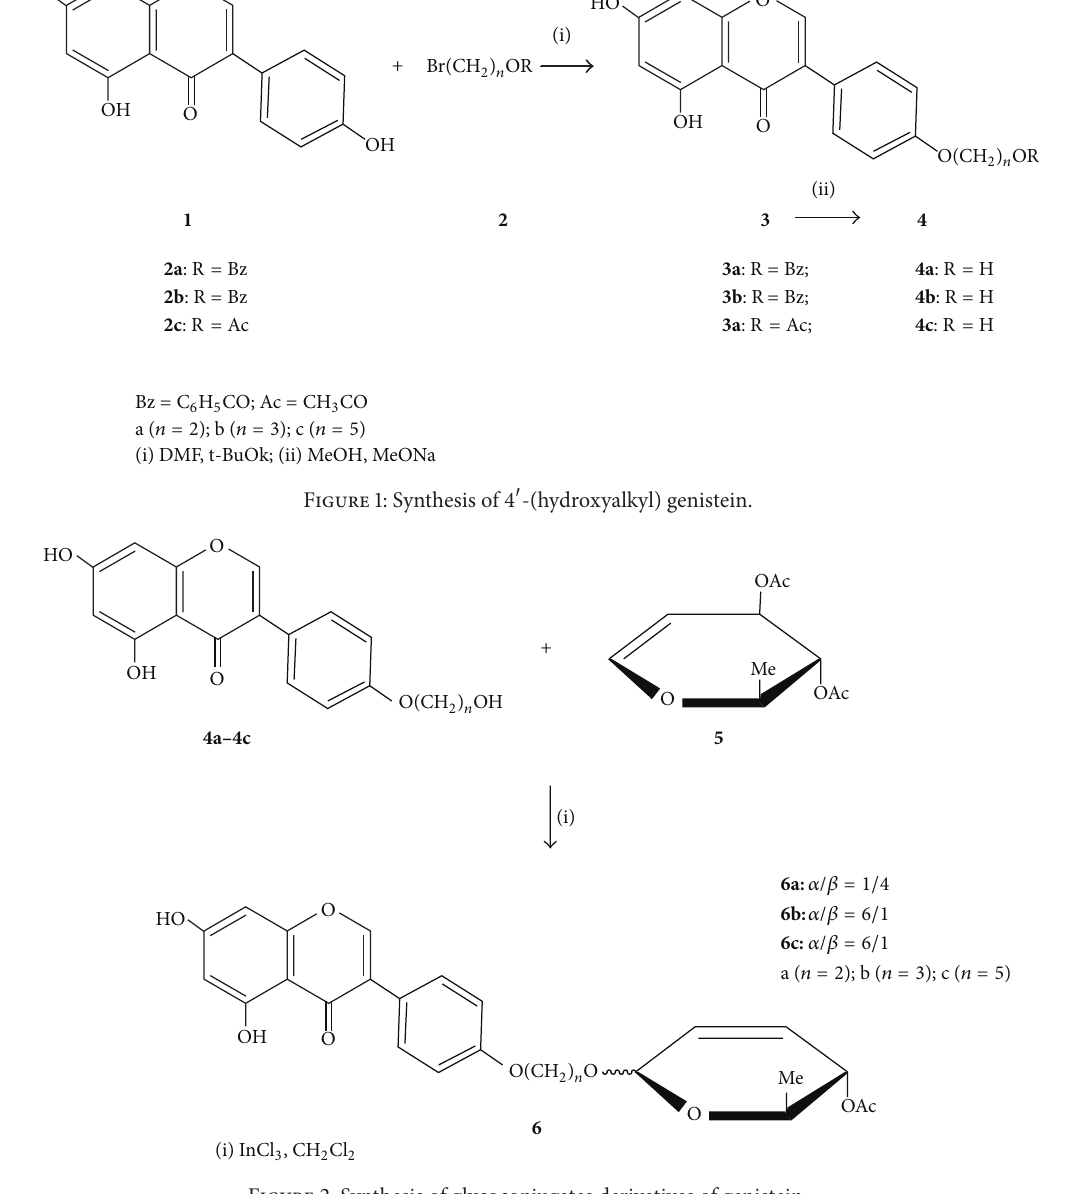
Figure 2: Synthesis of glycoconjugates derivatives of